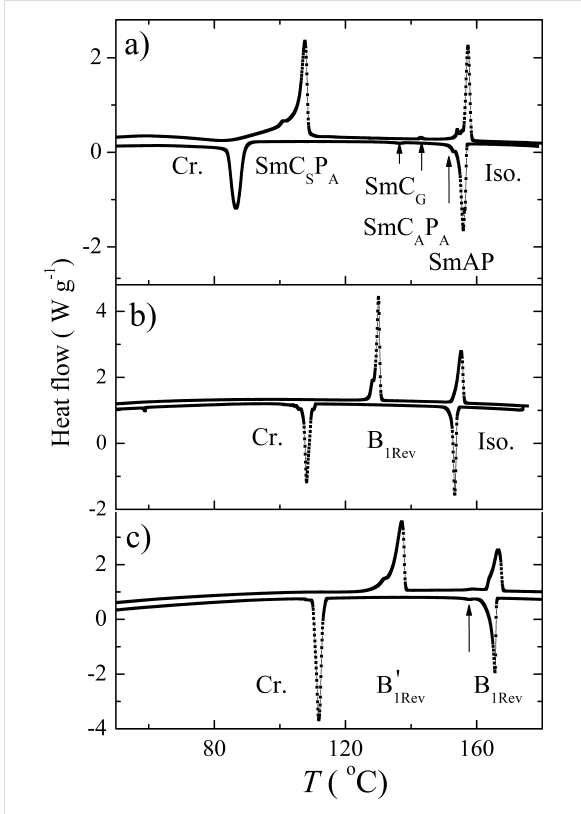
Figure 3: DSC plots for compounds a) IIb, b) IVb and c) Vb taken on second heating (upper curve) and cooling (lower curve) at a rate of 5 K min –1 . Mesophases are designated, arrows mark the phase